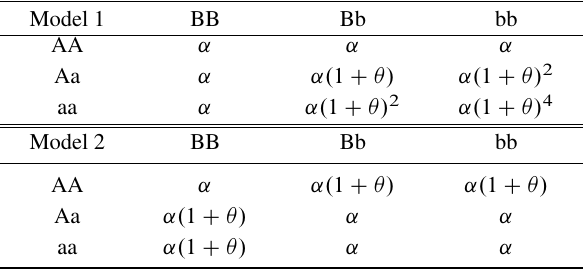
Table 2 Odds tables of disease Models 1 and 2. Model